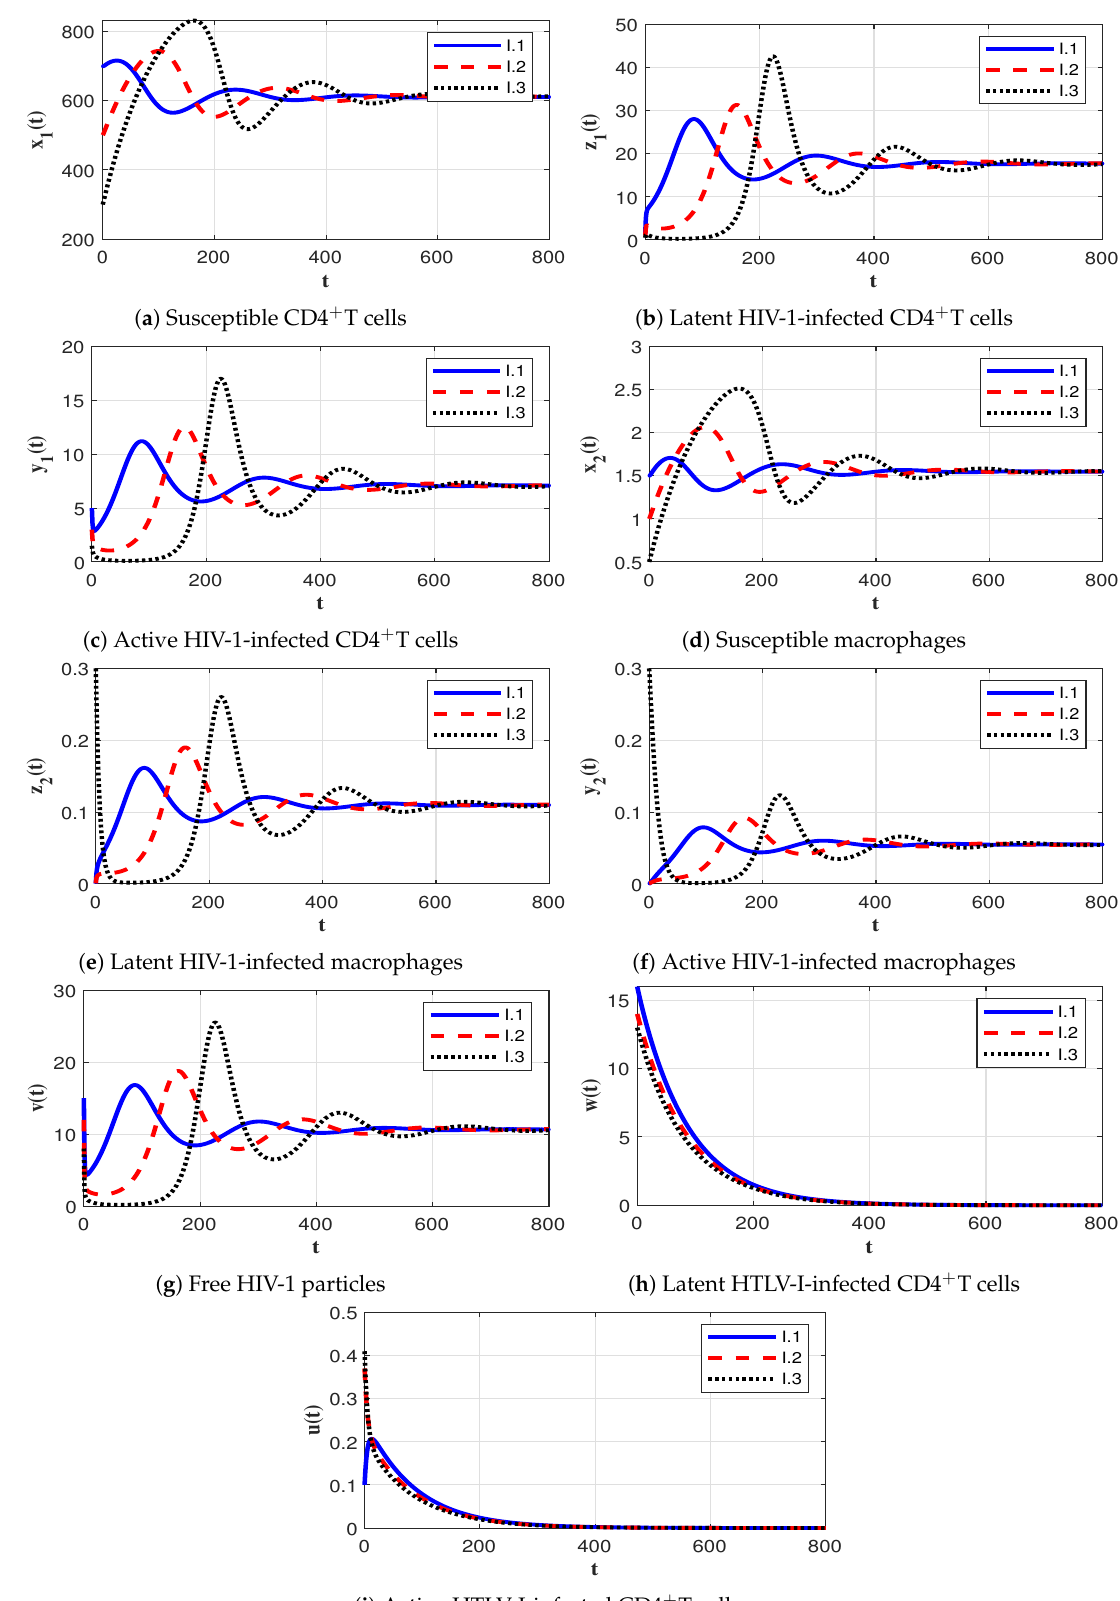
Figure 3. The equilibrium EP 1 = ( 611.87,17.56,7.02,1.55,0.1,0.054,10.54,0,0 ) is G.A.S whenever R > 1 and R ≤ 0 1